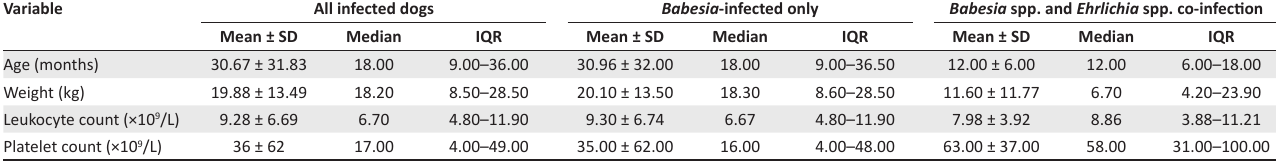
TABLE 1: Population characteristics, leukocyte count and platelet count for dogs with Babesia spp. and Ehrlichia spp. infection. Variable